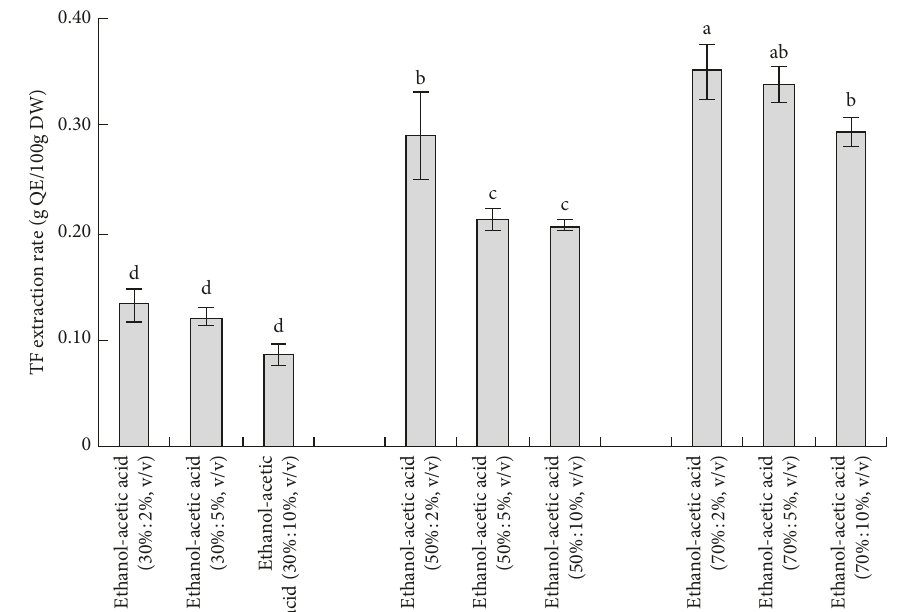
Figure 1: Effect of different combinations of ethanol and acetic acid in proportion on total flavonoids (TF) extraction